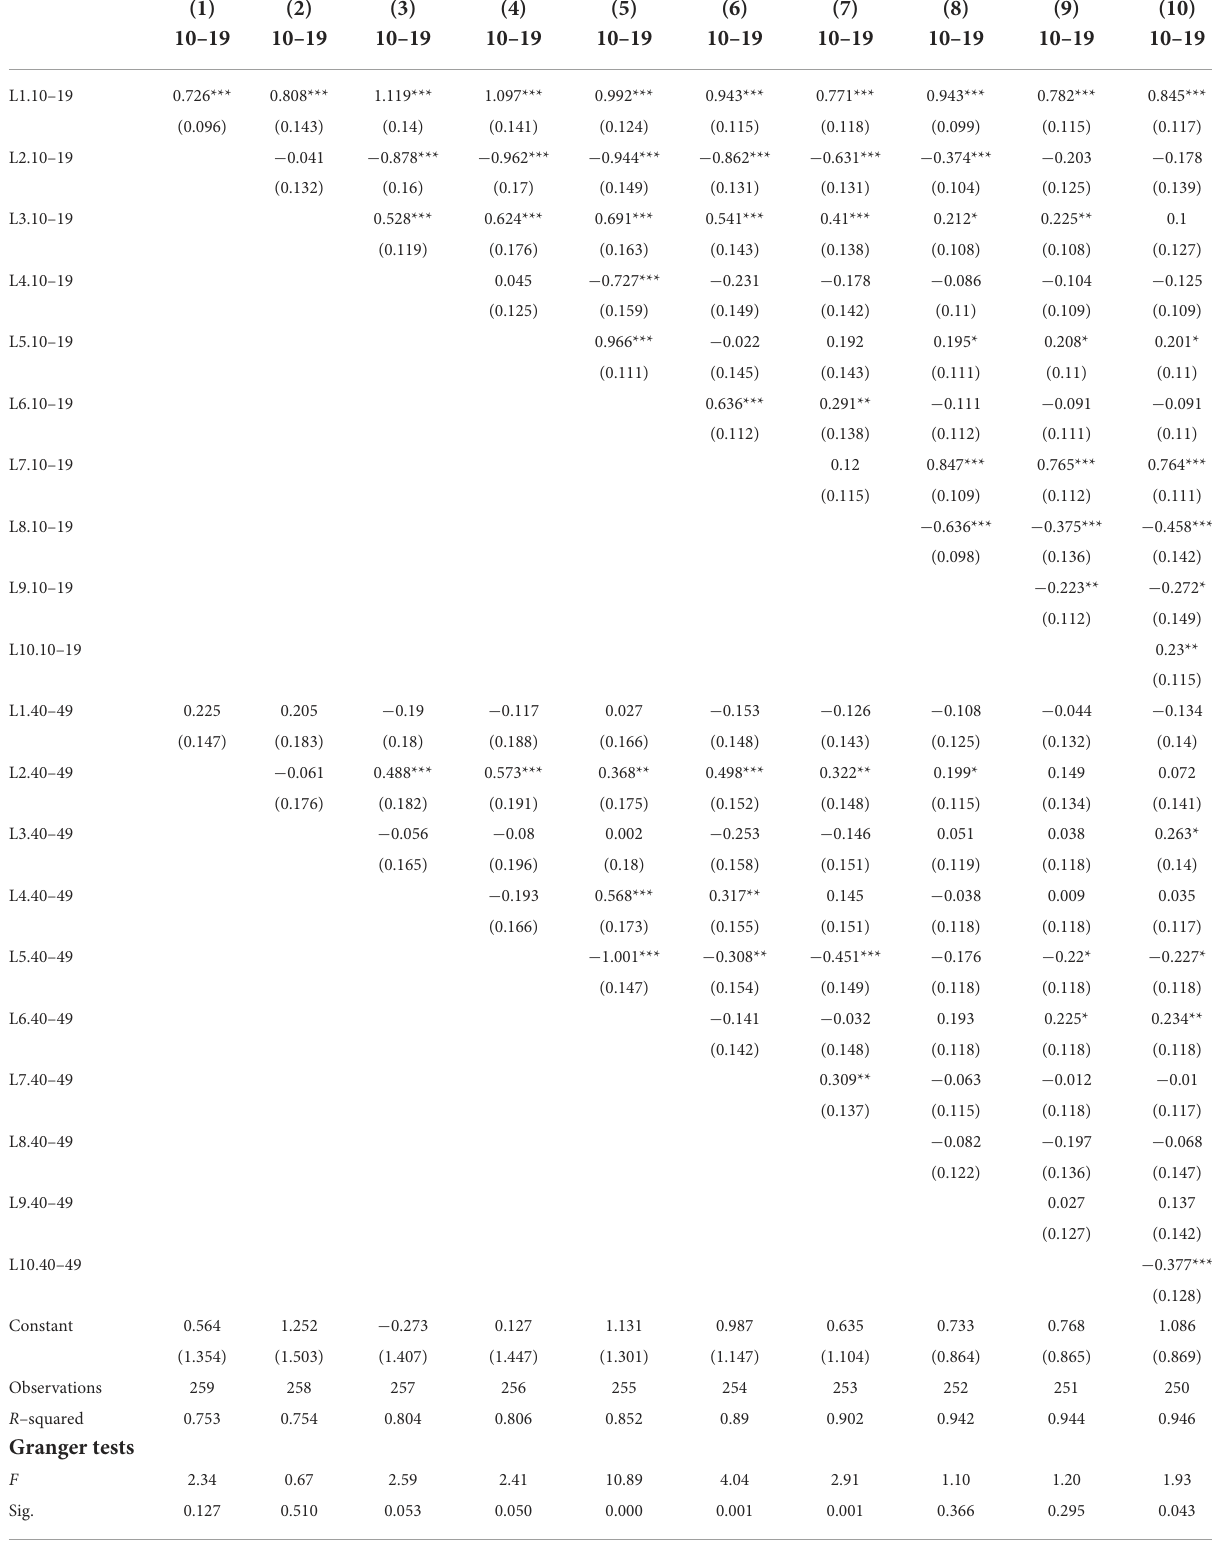
TABLE 4 Granger causality test for the 10–19 age–group series as dependent